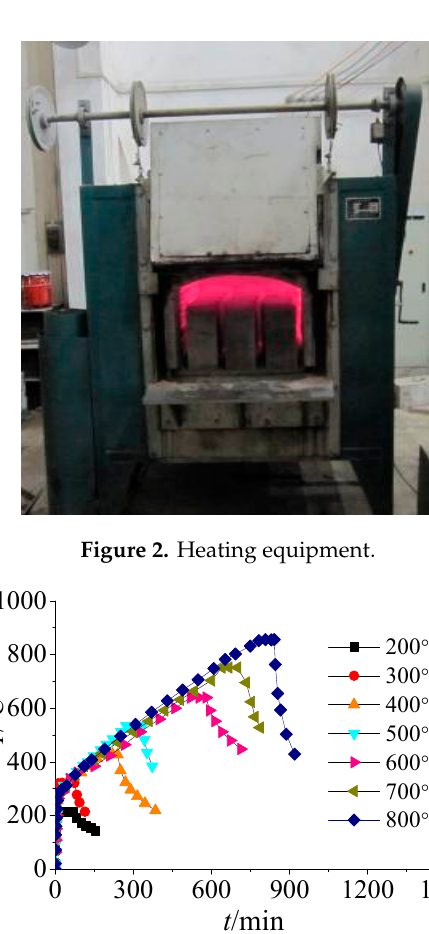
Figure 3. Temperature increase in the furnace.